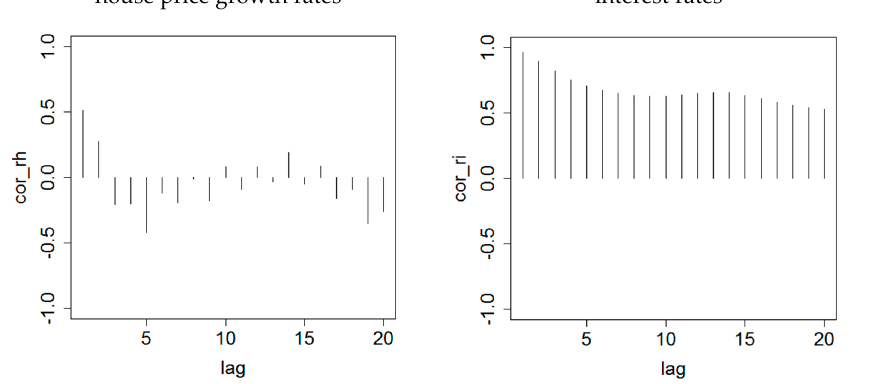
Figure 4. Australian quarterly residential property price index values (weighted average of Sydney, Melbourne, Brisbane, Adelaide, Perth, Hobart, Darwin and Canberra) and growth rates, and 3-month bank accepted bills yields, from September 2003 to June 2018.